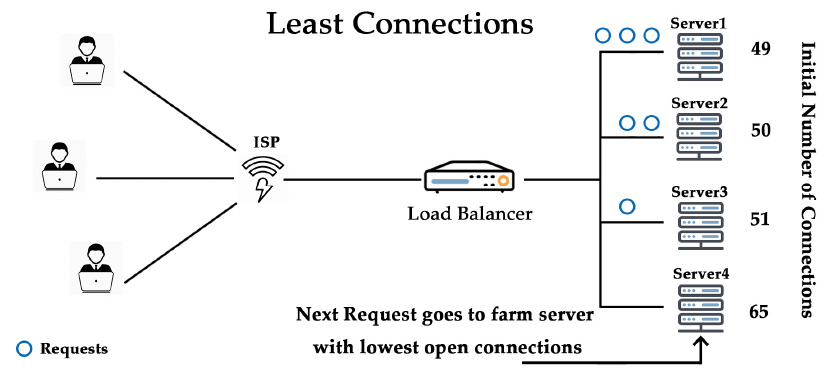
Figure 4. Least connection algorithm.